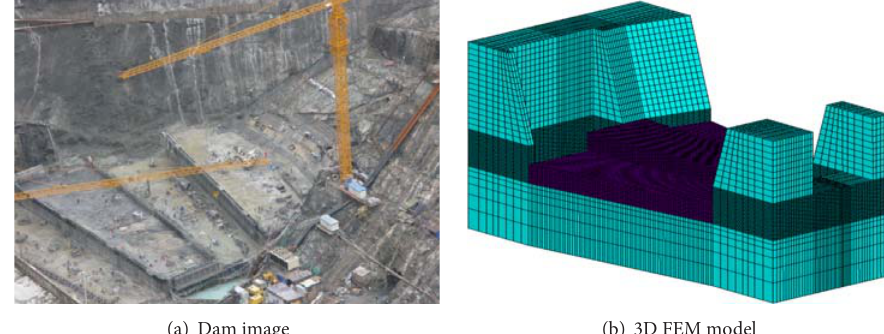
Figure 11: Image of Xiluodu Dam and 3D FEM model.